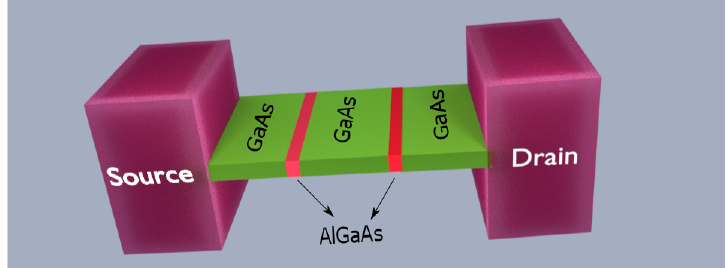
Figure 2. A 3D schematic of the RTD where the green material represents GaAs while the red represents AlGaAs. The alternating AlGaAs-GaAs-AlGaAs structure results in a potential well with discrete resonant